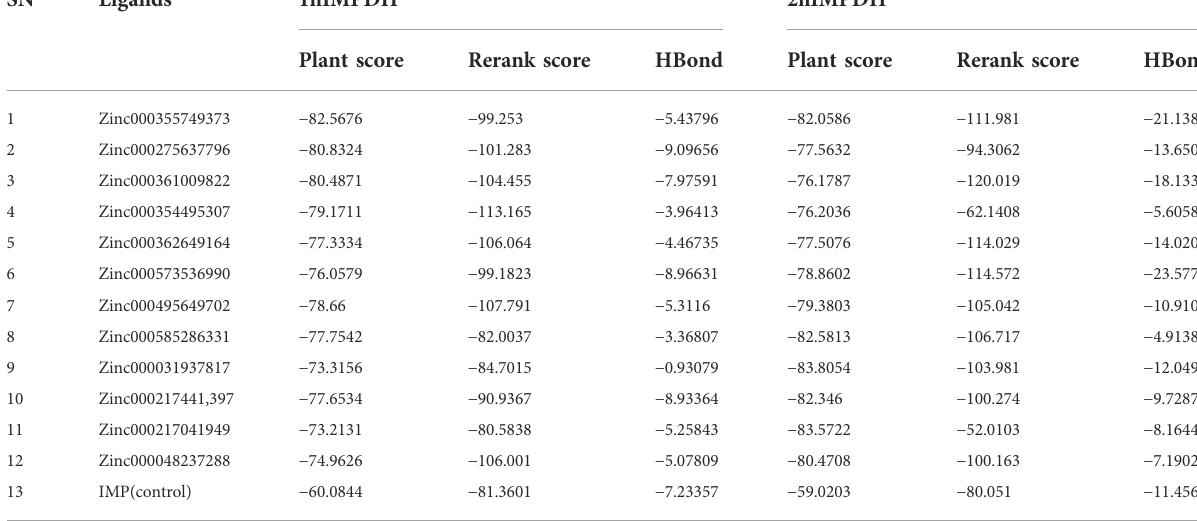
TABLE 1 Top ranked ligands based on binding af fi nity against both human IMPDH